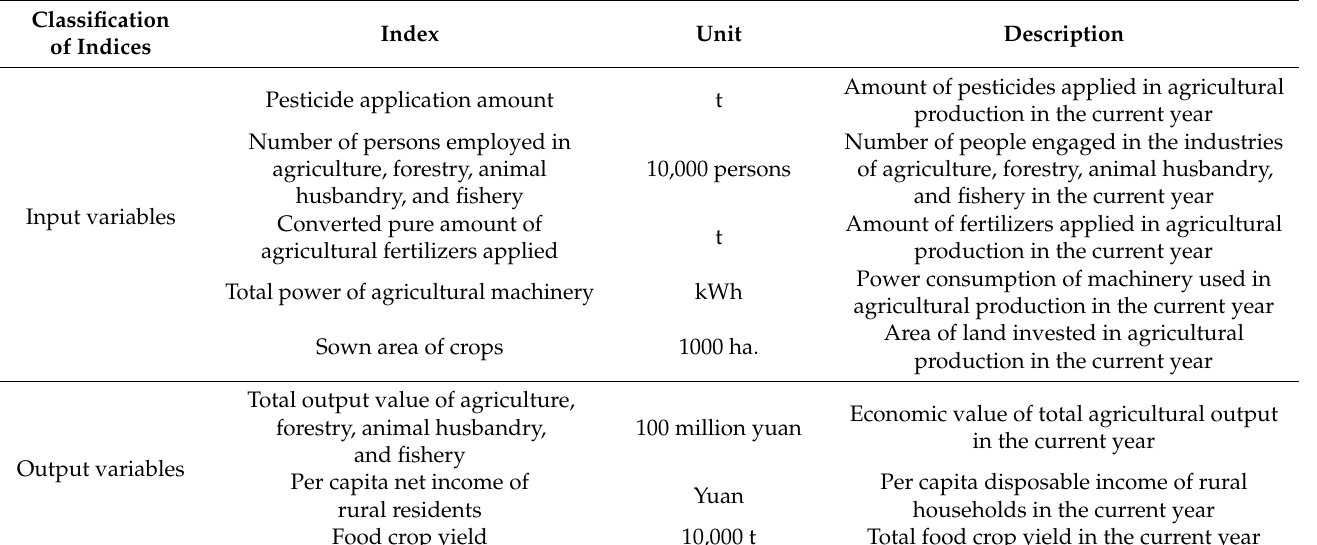
Table 1. Index system for evaluating the efficiency of the agricultural circular economy in Henan